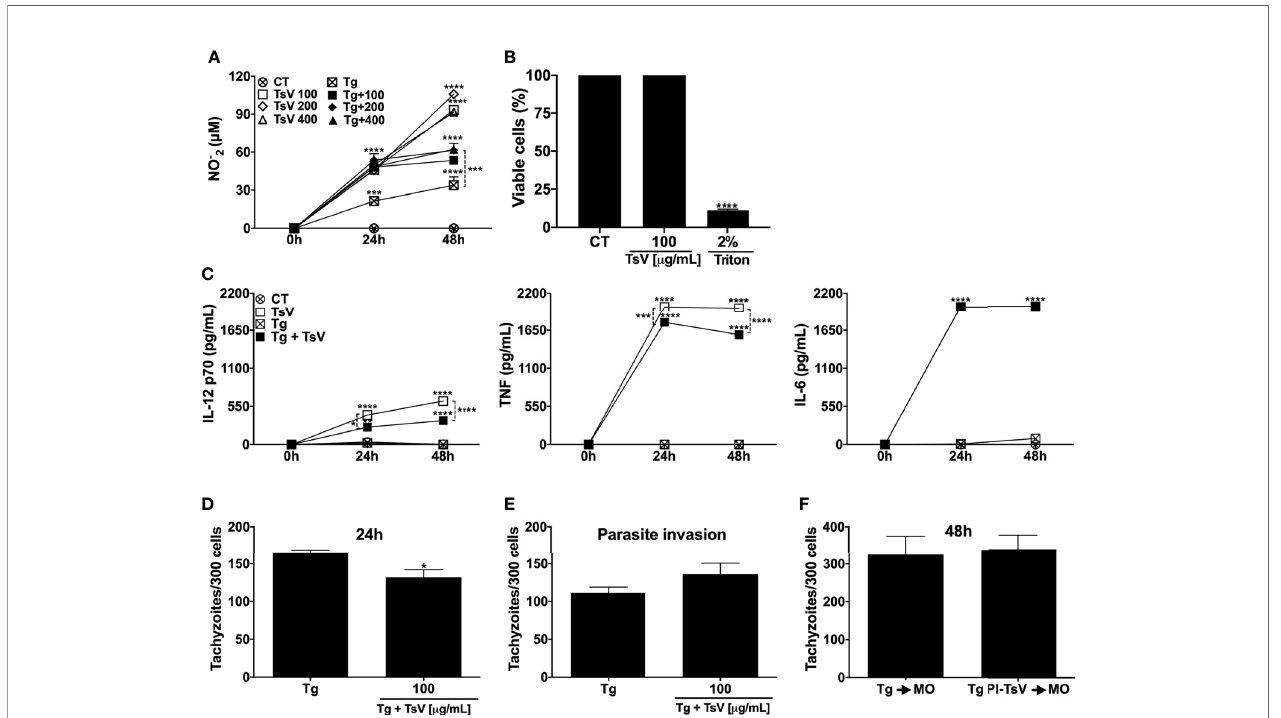
FIGURE 1 | TsV induces the production of in fl ammatory mediators by macrophages, reducing T. gondii replication. Peritoneal macrophages from C57Bl/6 female mice were cultured and infected (1:1 T. gondii : cell ratio) and/or stimulated with TsV (100, 200, or 400 µg/mL). After 24 and 48 h, the culture supernatants were collected for nitric oxide (A) and IL-12p70, TNF, and IL-6 cytokine (C) measurements. Viability assay was performed on the adhering cells at 48 h after TsV (100 µg/ mL) stimulation (B) . Intracellular parasite counts were performed on fi xed and stained cells at 24 h (D) or 4 h (E) post-infection/stimulus. Macrophages were infected with TsV (100 µg/mL)-pre-incubated tachyzoites forms ( “ PI ” ) and 48 h after infection, the cells were fi xed and stained for intracellular parasite quanti fi cation (F) . “ CT ” = control (non-stimulated cells). “ Tg ” = T. gondii -infected macrophage. Each point represents means ± SEM of one of two independent experiments, * p ≤ 0.05; *** p < 0.001; **** p <